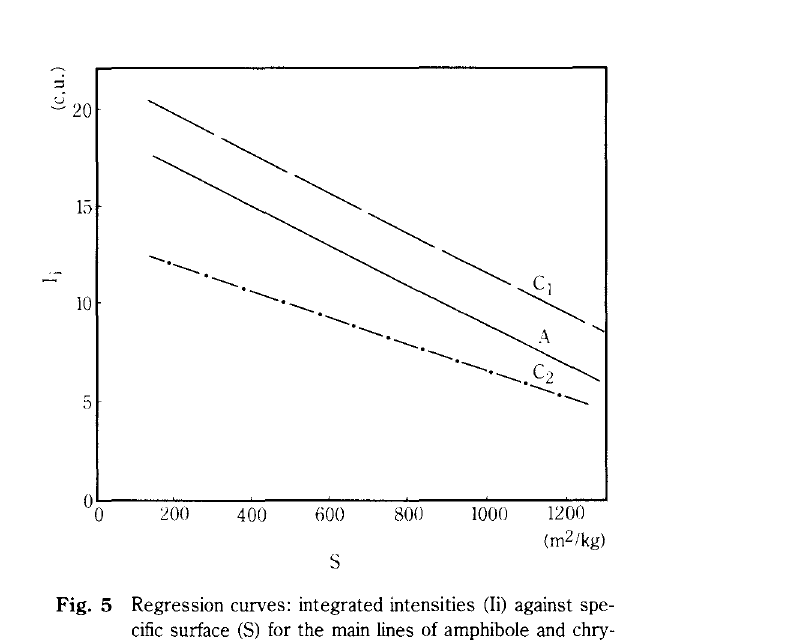
Regression curves: integrated intensities (Ii) against spe cific surface (S) for the main lines of amphibole and chry sotile asbestos, ground by a hand mortar and pestle (symbols as in Fig.